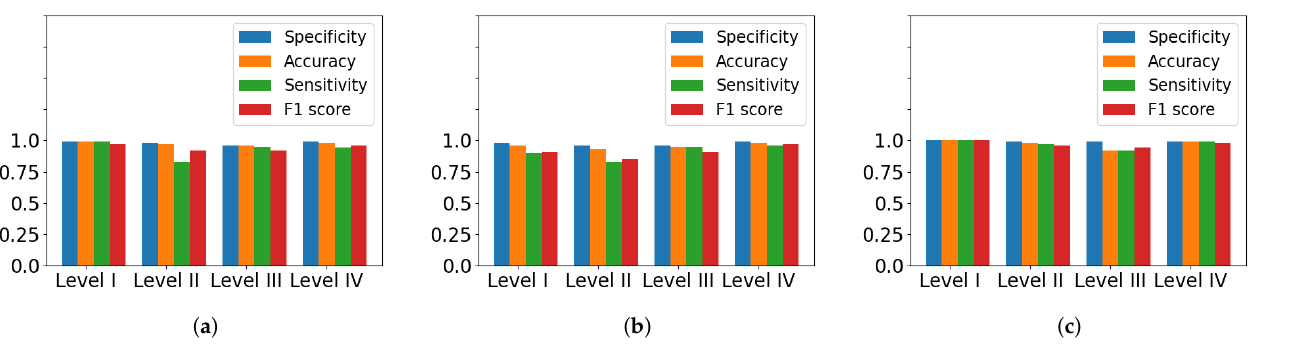
Figure 9. Visualization of the general performance metrics for the ( a ) KNN, ( b ) SVM and